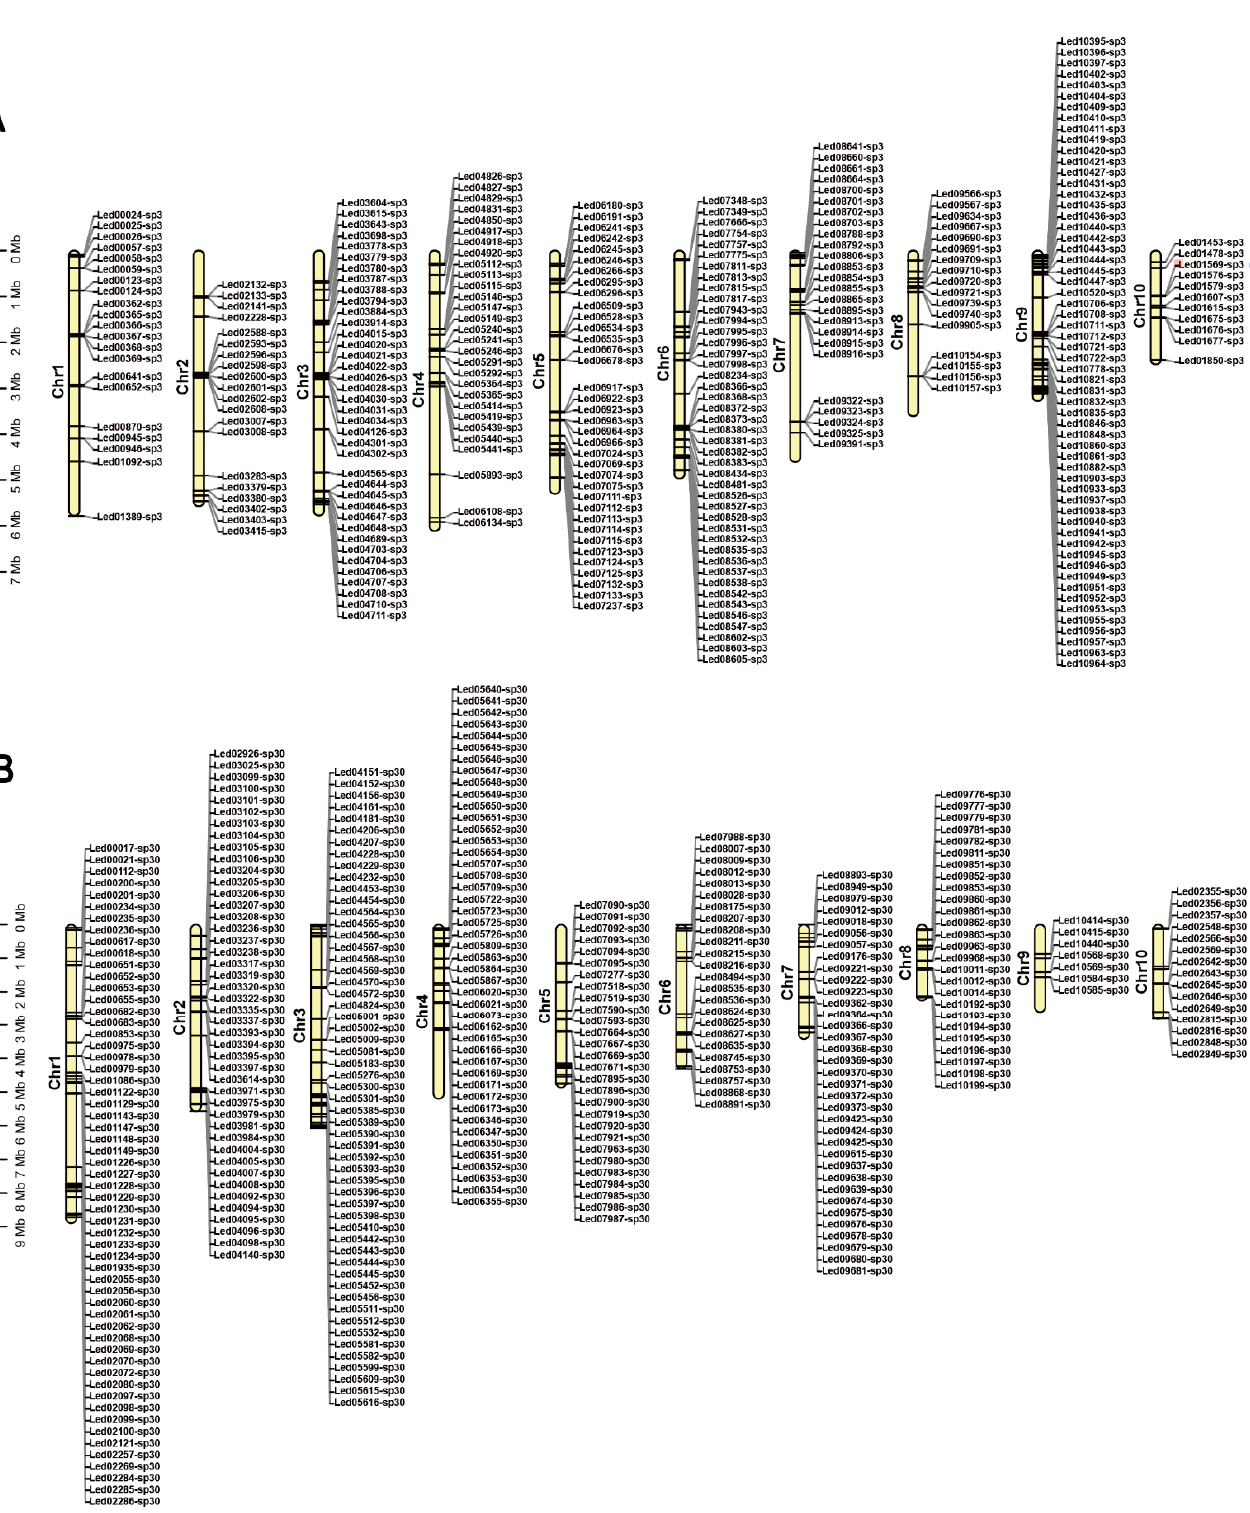
Figure 5 . Location of the unique genes found within each of the two monokaryons on each chromosome. ( A ) Unique genes in strain SP3. ( B ) Unique genes in strain SP30.